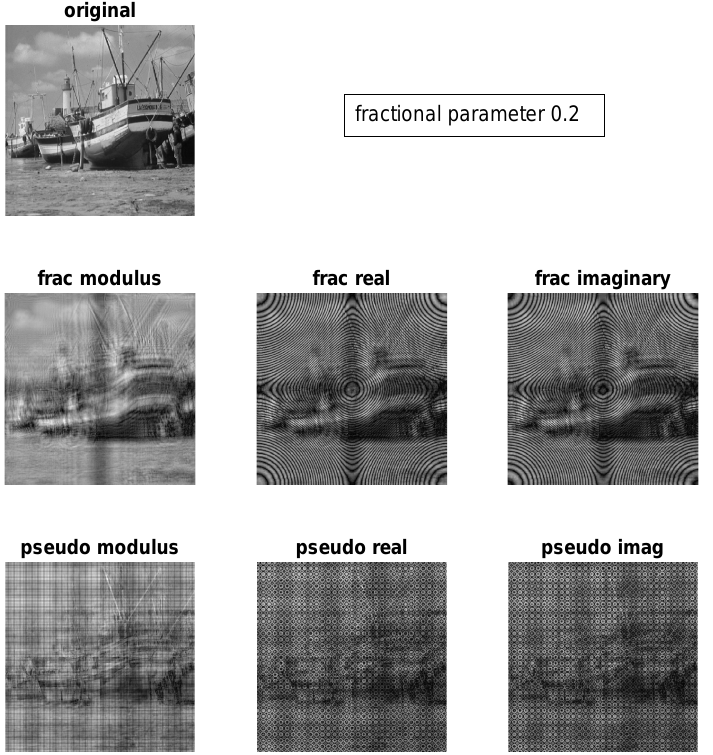
Figure 4. Comparison of DFrFT and DPFrFT of the grayscale image “Boat” for fractional parameter a =